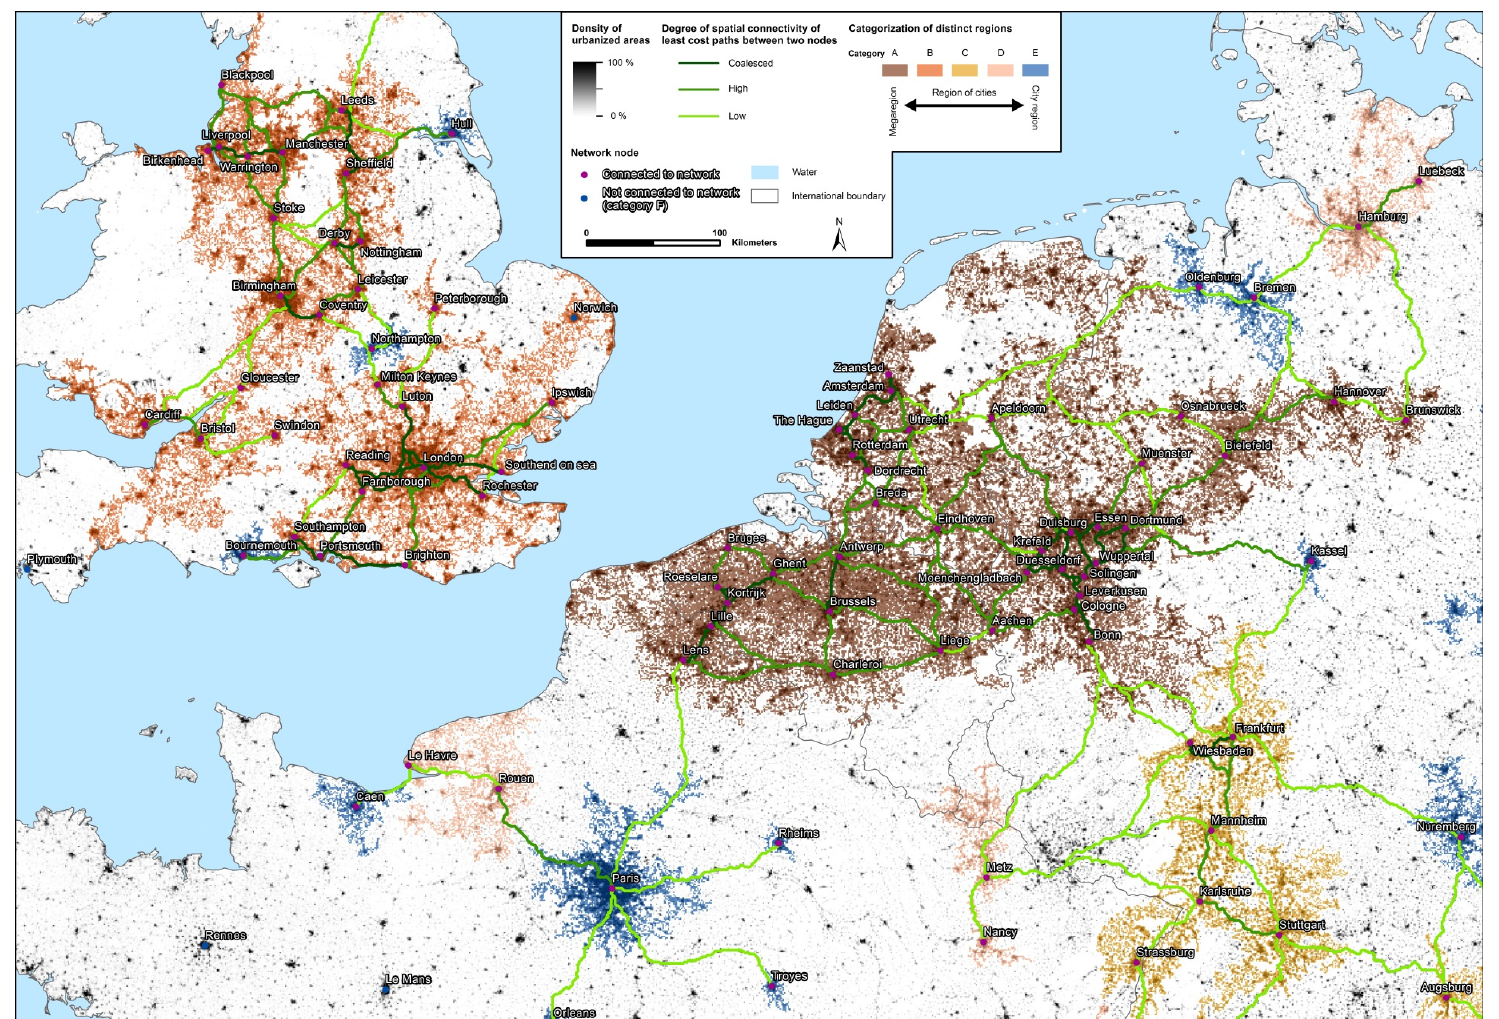
Figure 4. Identified urban nodes, conjugation lines classified as connected and the categorized delimited regions from the detail in Figure 3.